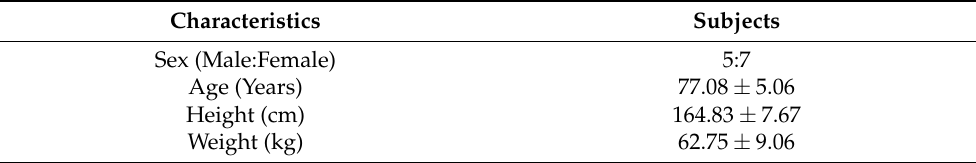
Table 2. Subject Table 2. Subject characteristics.